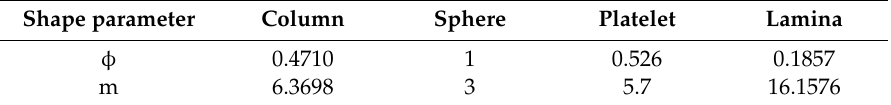
Table 2. The values of shape parameters as